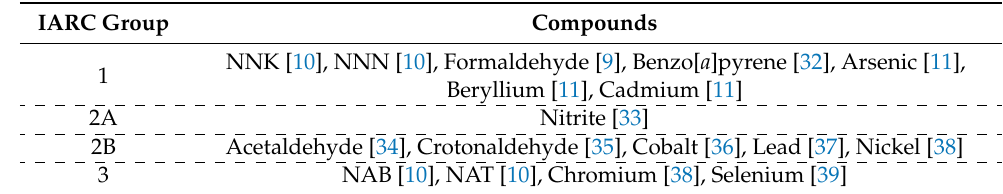
Table 6. IARC designations for the HPHCs of